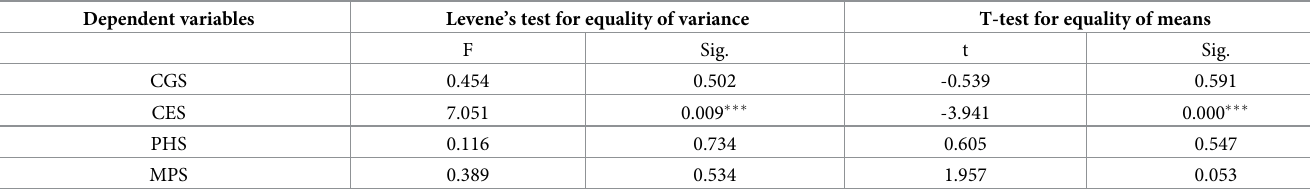
Table 5. T-test for the influence of MICE degree background on the skills of MICE students. Dependent